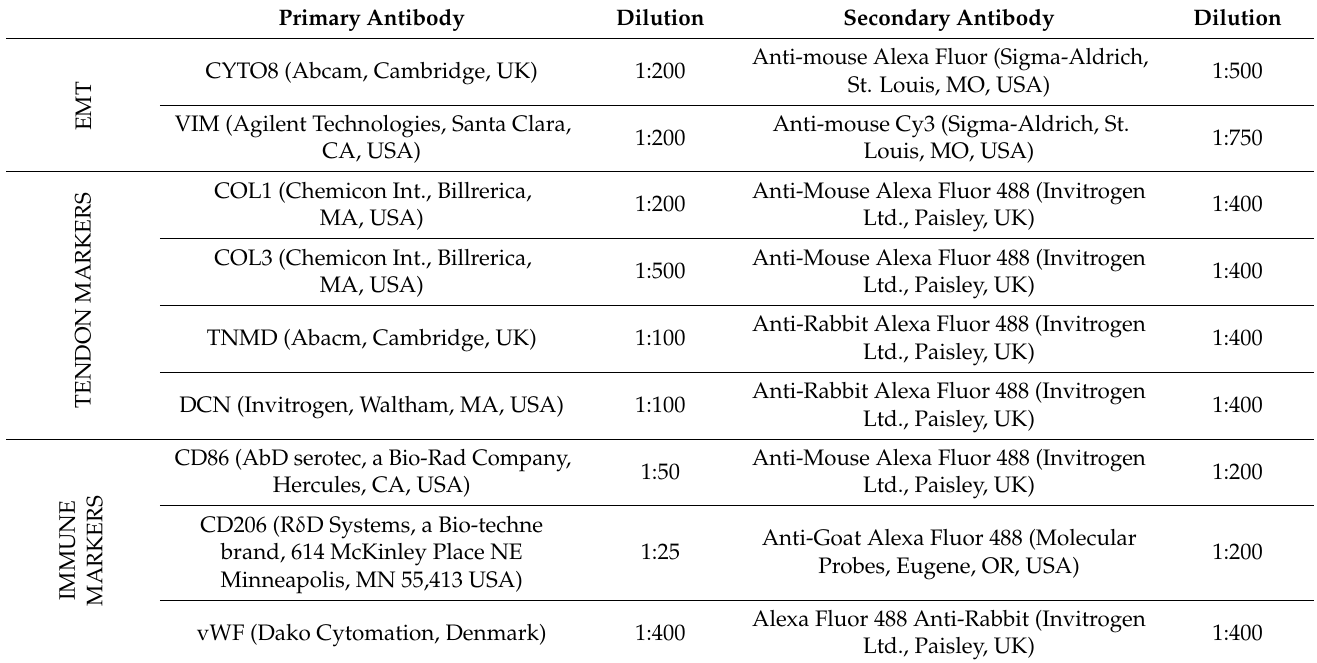
Table 2. Primary and secondary antibodies used for ICC and tendon analysis. Primary Antibody Dilution Secondary Antibody